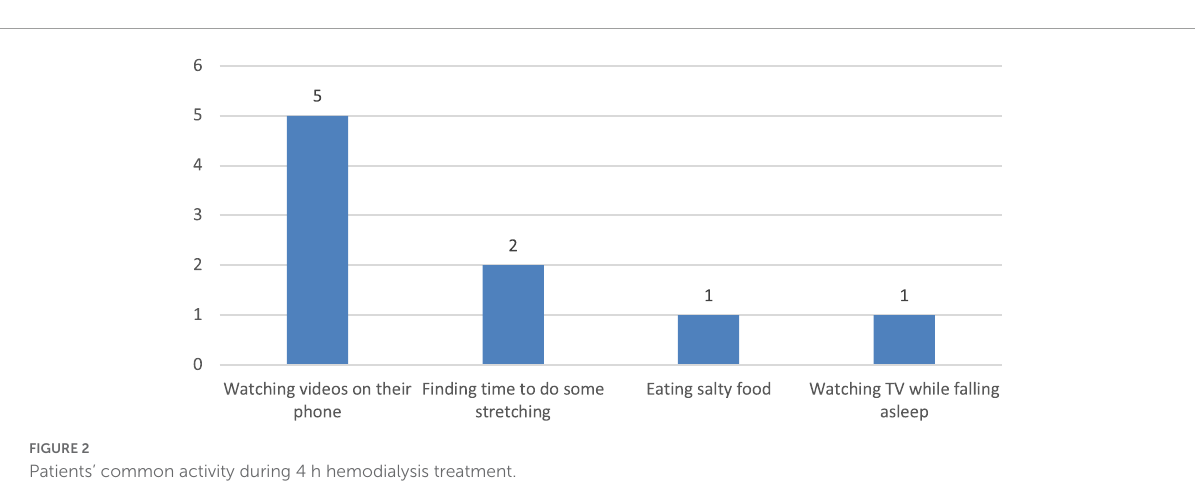
FIGURE2 Patients’ common activity during 4 h hemodialysis treatment.